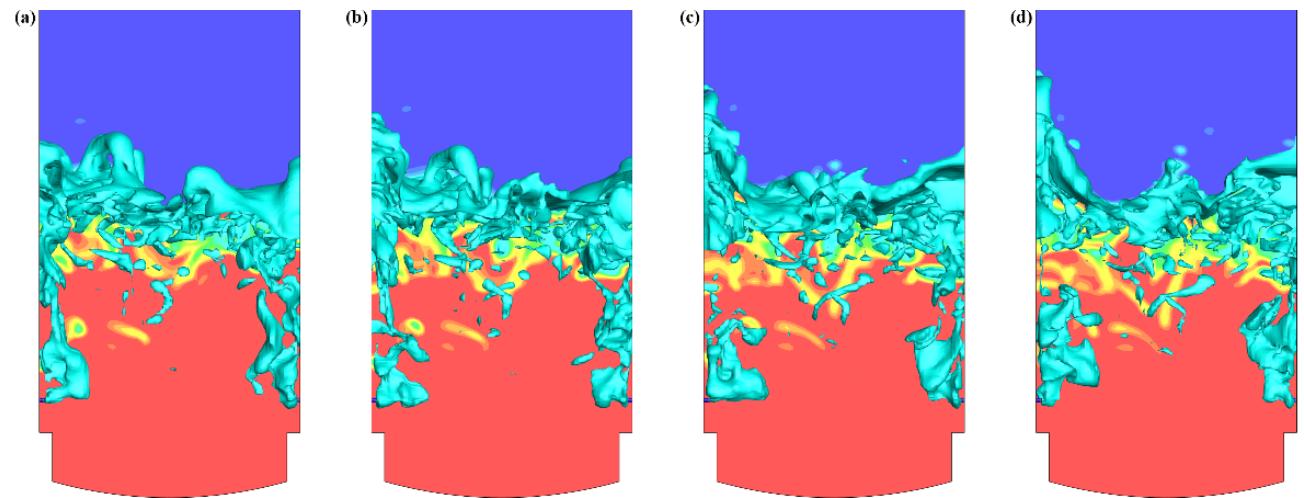
Figure 4. Profile of slag sp la sh height process: ( a ) t = 6.10 s, ( b ) = 6.15 s, ( c ) = 6.20 s, ( d ) = 6.25 s. Figure 4. Profile of slag splash height process: ( a ) t = 6.10 s, ( b ) = 6.15 s, ( c ) = 6.20 s, ( d ) = 6.25 s.